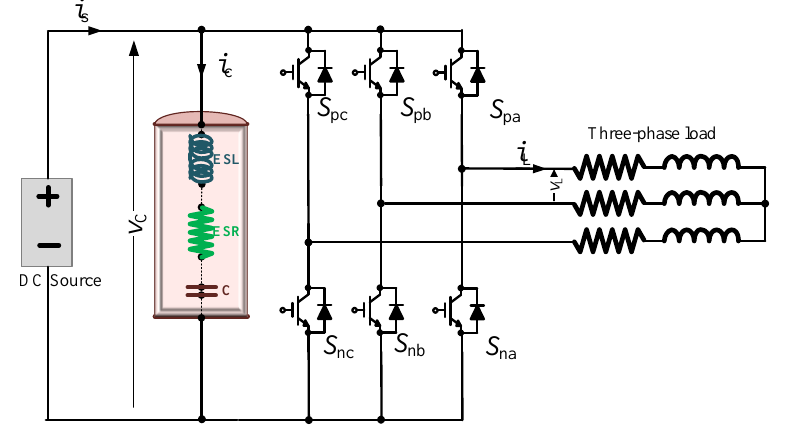
Figure 3. Three-phase inverter system.